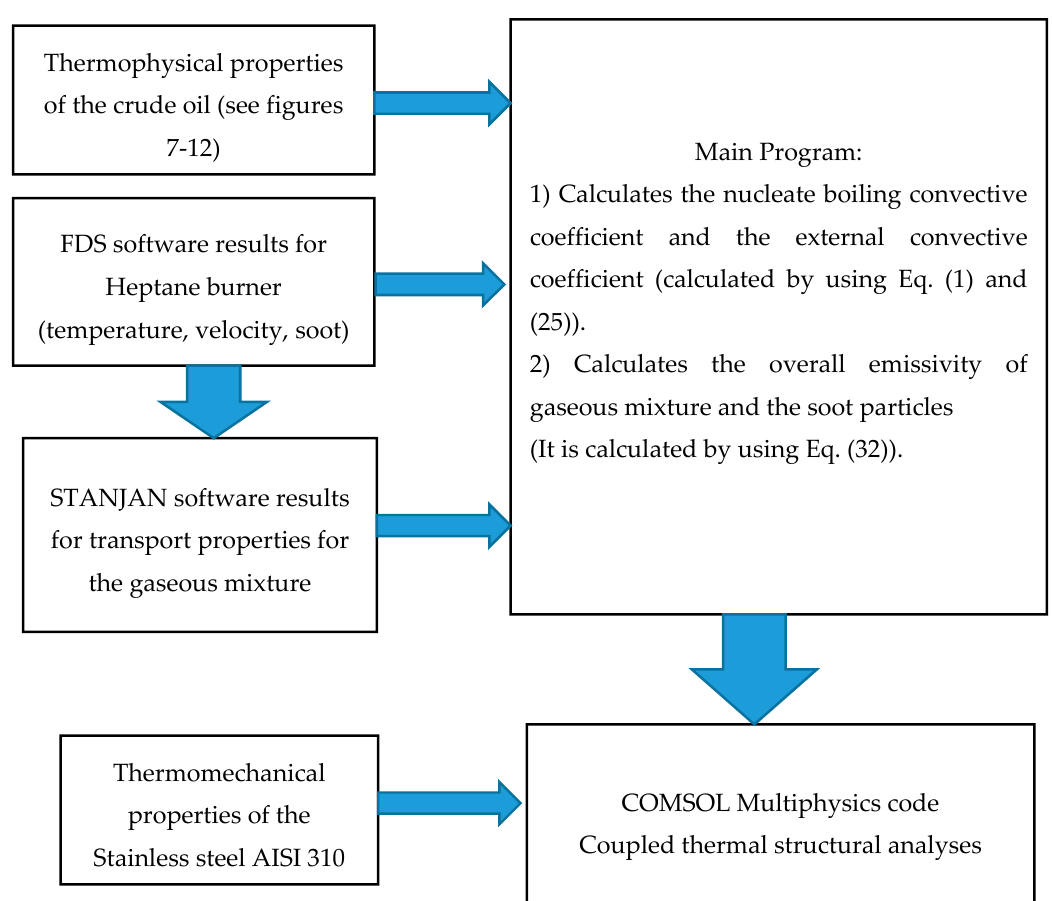
Figure 17. Schematics of the computational process algorithm.